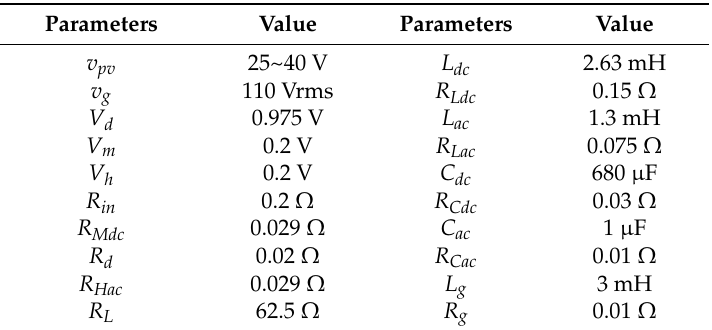
Table 1. Simulation and experimental parameters for model validation.